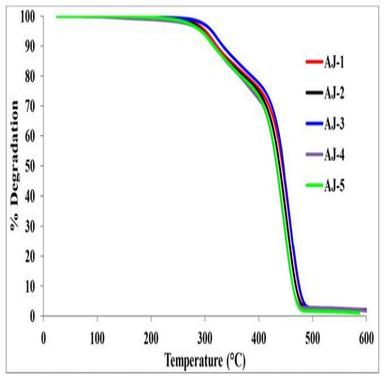
TGA thermograms of Chitosan/starch based PU.